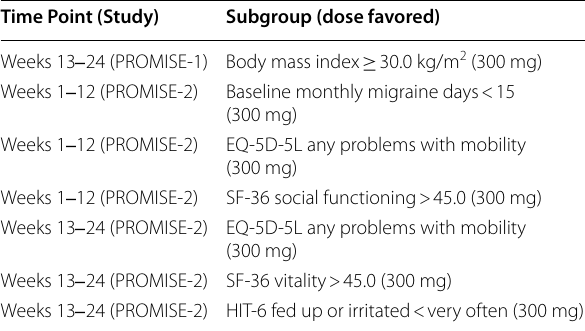
Table 1 List of parameters measured in PROMISE-1 and PROMISE-2 where 300-mg was favored over 100-mg dose in predicting 50% migraine responder rate ≥